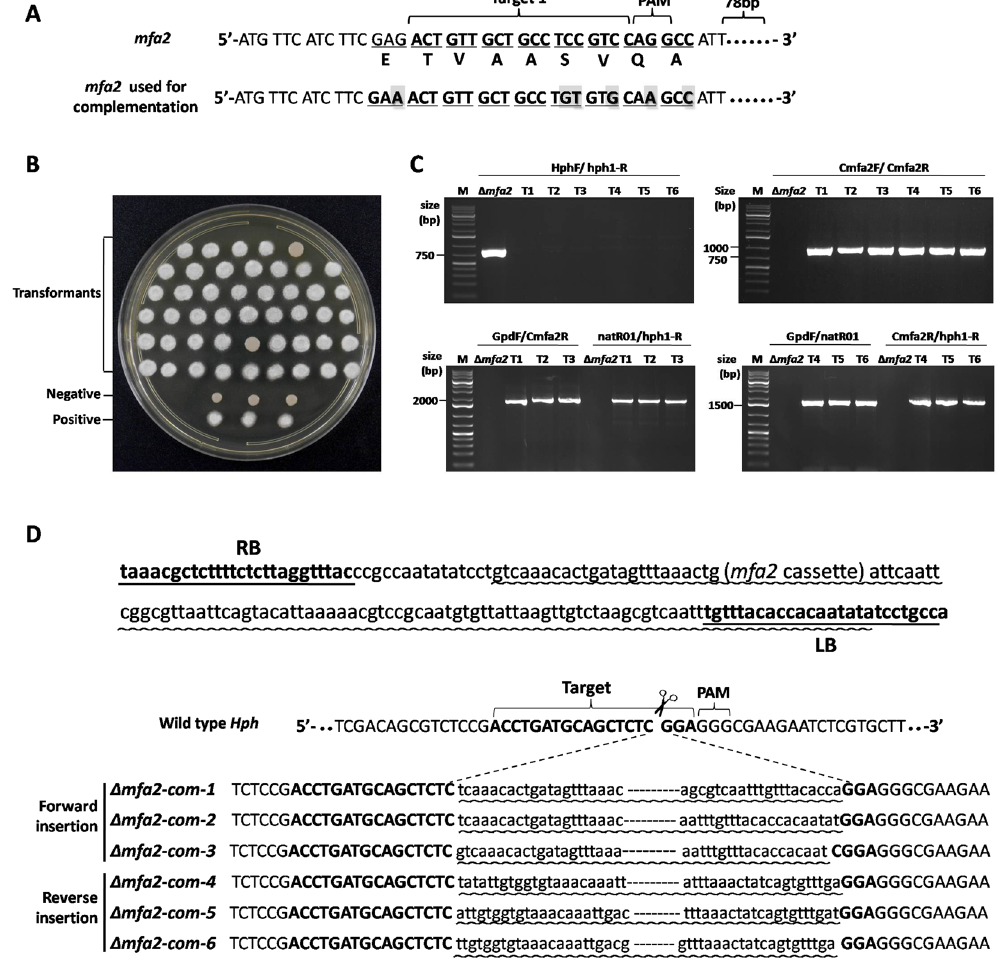
Figure 3. Identification and characterization of Mfa2 complementation transformants. ( A ) Nucleotide and amino acid sequences of wild-type and base-modified Mfa2 target locus. ( B ) Mating assays of Mfa2 complemented transformants. The fluffy colonies are the result of successful mating, while the dense colonies indicate a fail in mating. The negative control is haploid JG35 with yeast-like colony, and the positive control is a mix of JG35/JG36 with filamentous hyphae. ( C ) PCR characterization of the complemented transformants. The up/left: detection of the Hph gene; the up/right: detection of the introduced Mfa2 ; the down/left: forward insertion, the sizes of PCR products were 1686 bp with primer pair GpdF/Cmfa2R and 1676 bp with primer pair natR01/hph1-R; the down/right: reverse insertion, the sizes of PCR products were 1624 bp with primer pair GpdF/natR01 and 1738 bp with primer pair Cmfa2R/hph1-R. ( D ) Sequences of the Hph flanking the insert at target locus of the complemented transformants. Underlined are RB and LB regions. The insertion regions are marked with wavy line. As could been seen, in both forward or reverse insertions, the whole RB and a small portion of the cassette at the 5 ′ end were lost, but only 8–15 LB nucleotides at the far most 3 ′ end were lost.